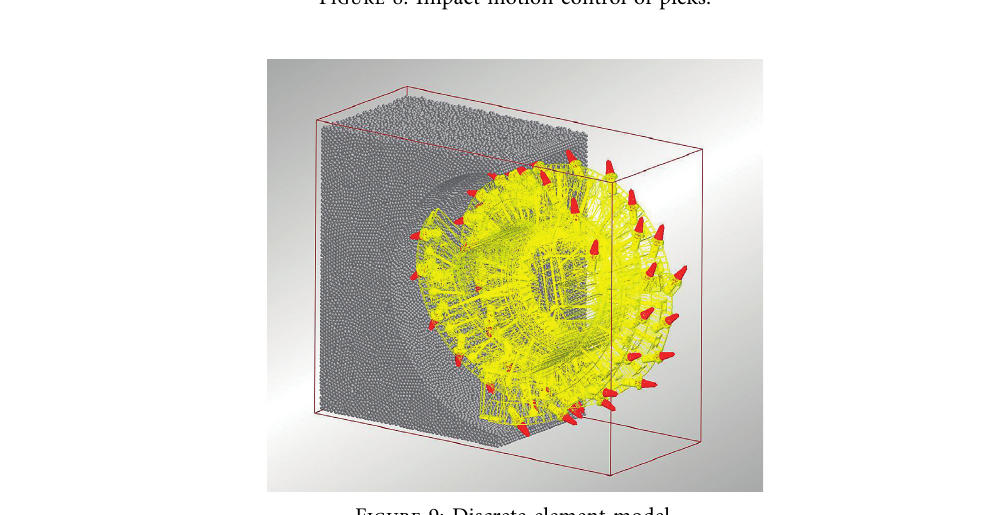
Figure 8: Impact motion control of